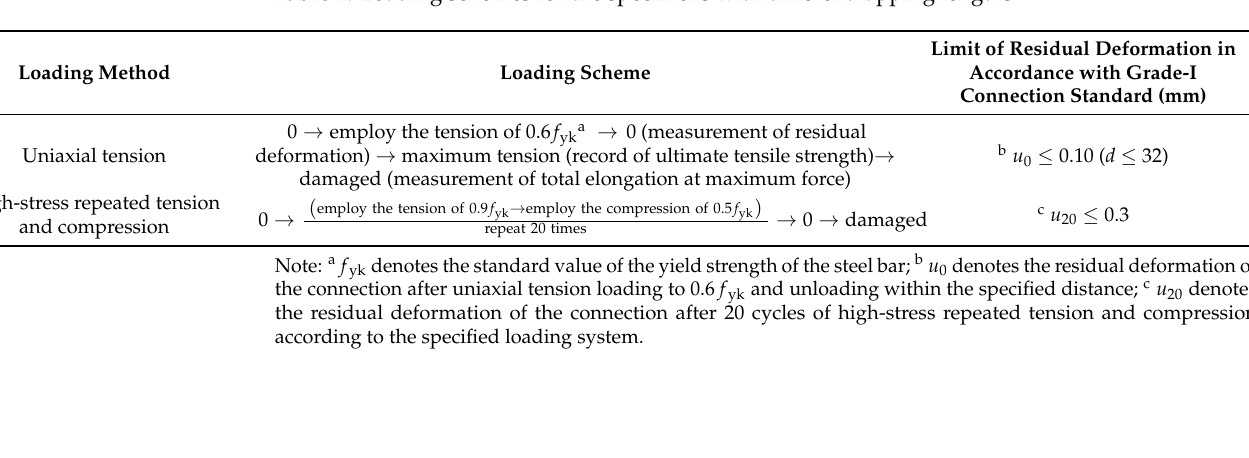
Table 2. Loading schemes for the specimens with different lapping